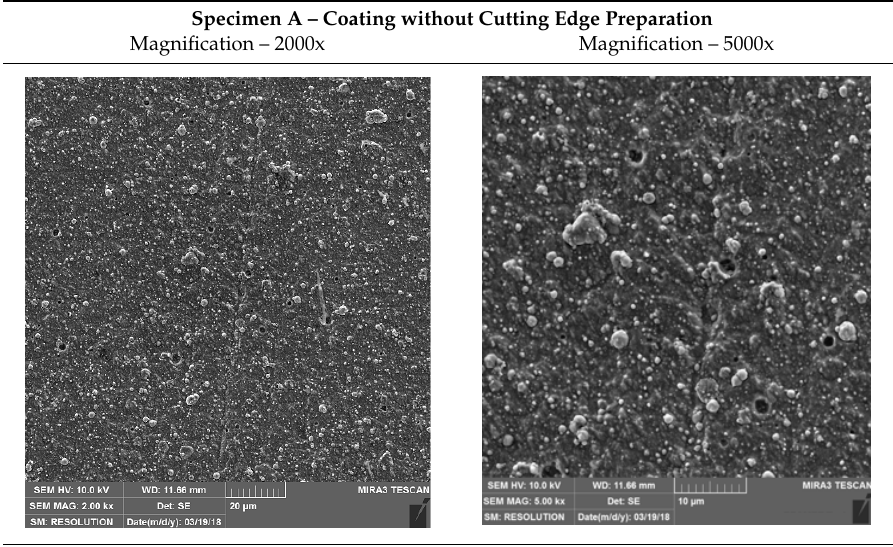
Table 5. Occurrence of droplets before and after cutting edge